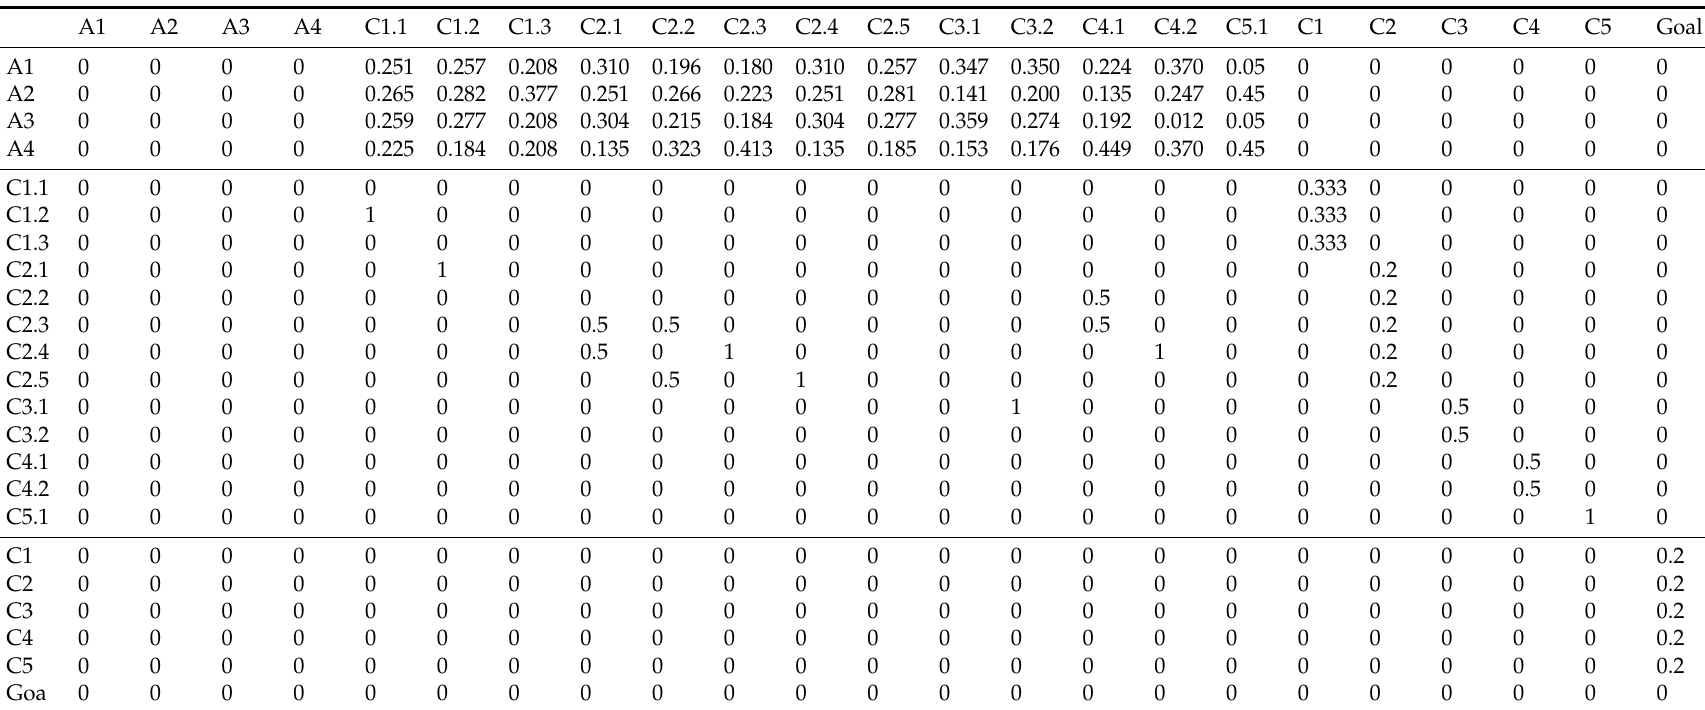
Table A2. ANP unweighted